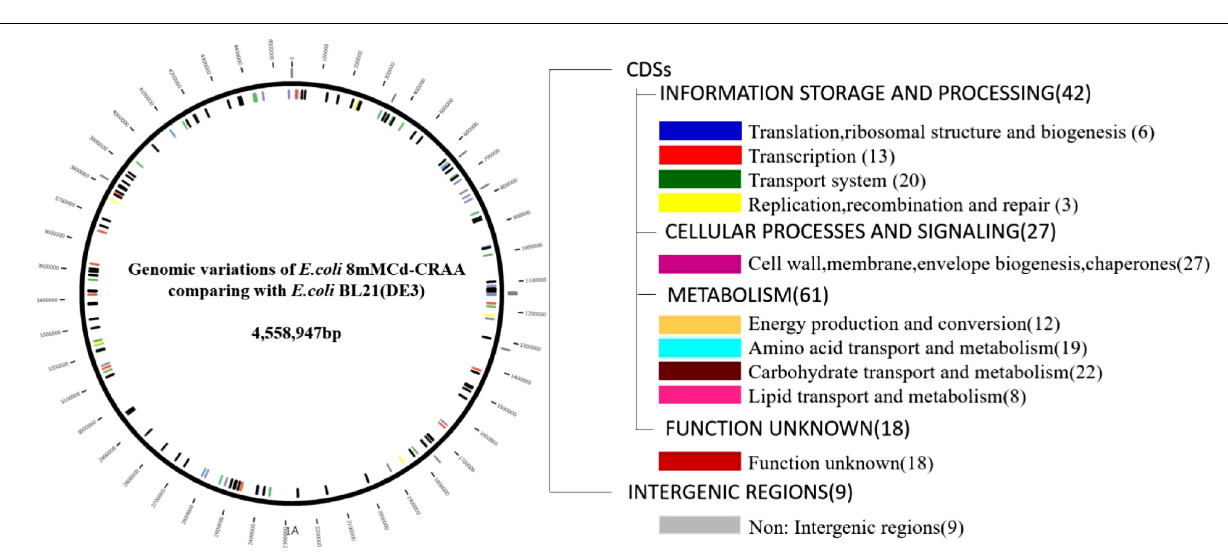
FIGURE 8 | Map and categories of all genomic mutations in Escherichia coli 8mM-CRAA relative to its ancestor wild-type strain E. coli BL21(DE3). Mutations that occurred in coding sequences (CDSs) and intergenic regions are marked inside and outside of the left circle, respectively. The numbers in parentheses on the right are the total numbers of mutations in each